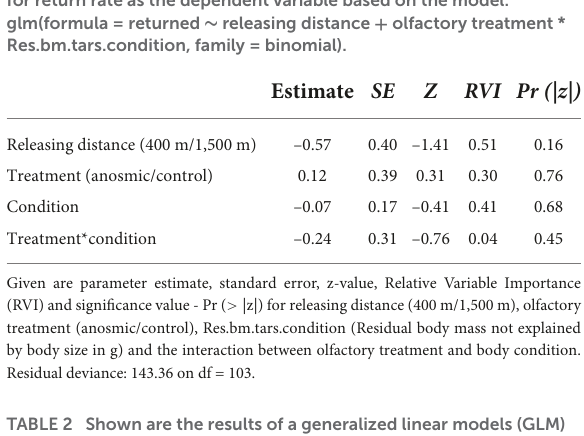
TABLE 2 Shown are the results of a generalized linear models (GLM) for return time as the dependent variable based on the